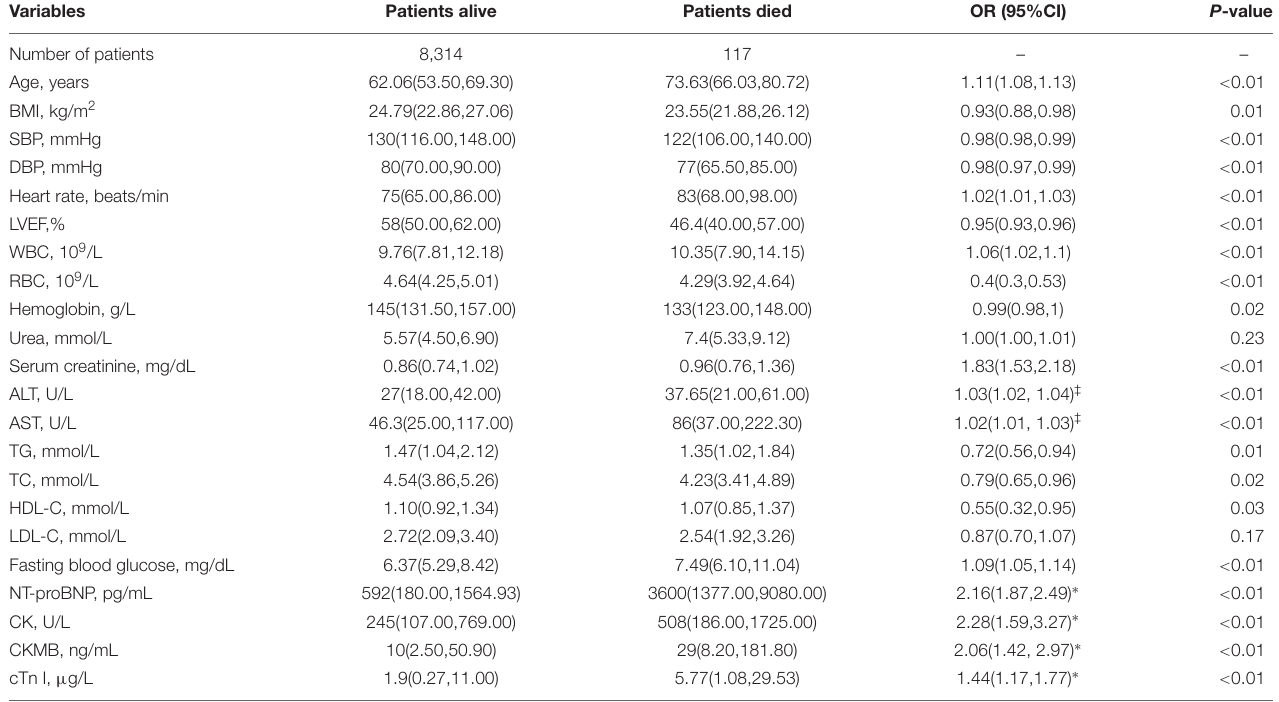
TABLE 2 | Univariate analysis between baseline characteristics (continuous variables) and in-hospital mortality in the training cohort.